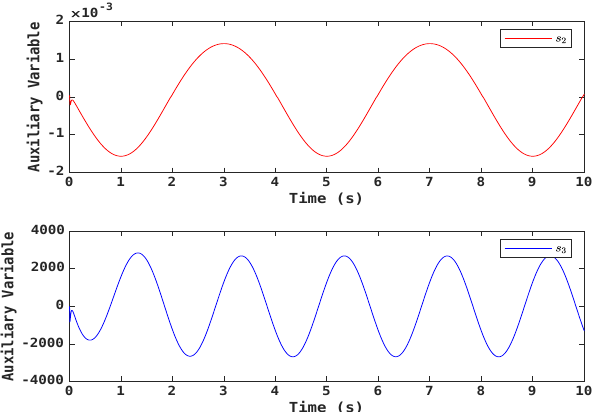
Figure 7. The dummy control variables of